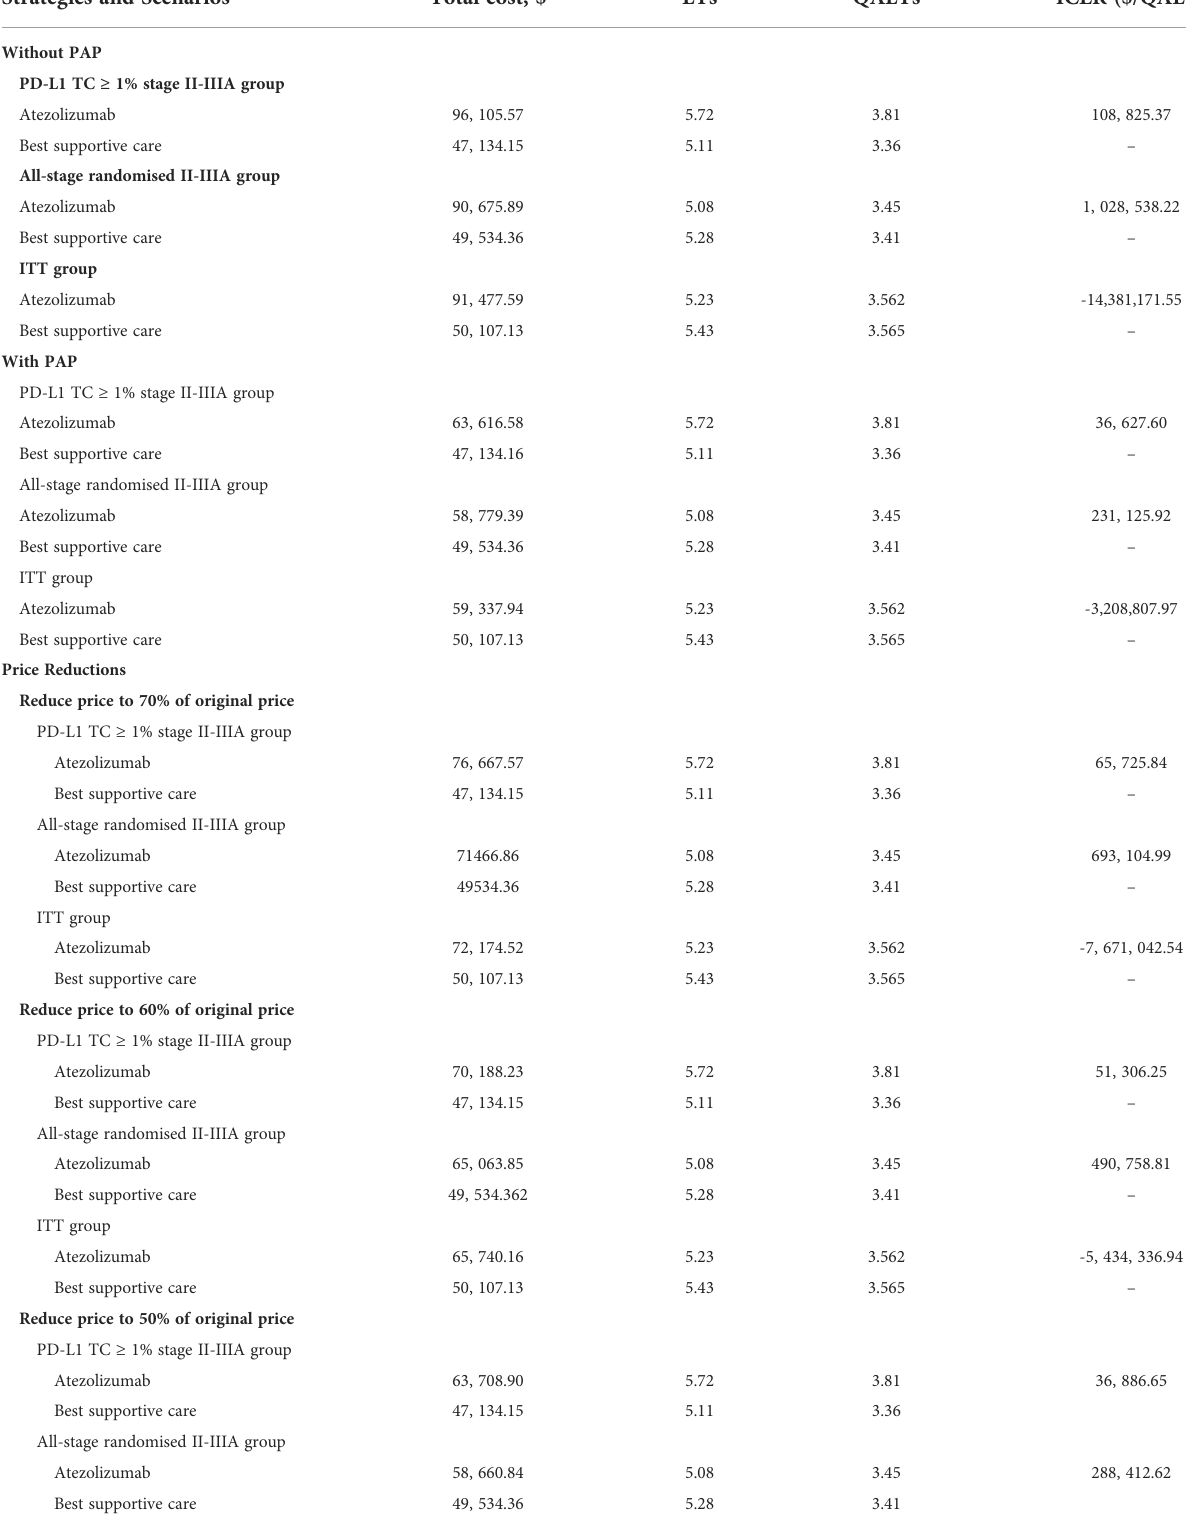
TABLE 2 Base-case